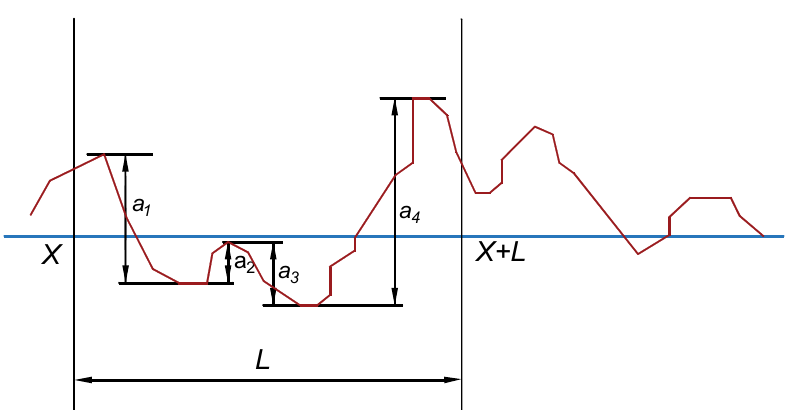
Figure 3. Calculation of peak-to-peak values of corrugation.